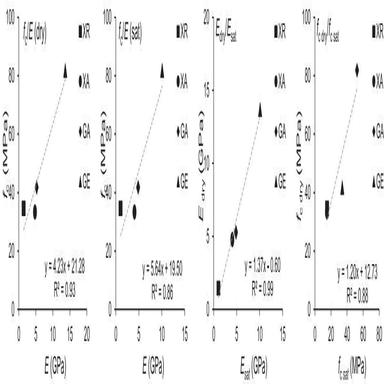
Correlation for fc and E mechanical parameters for dry and saturated specimens.